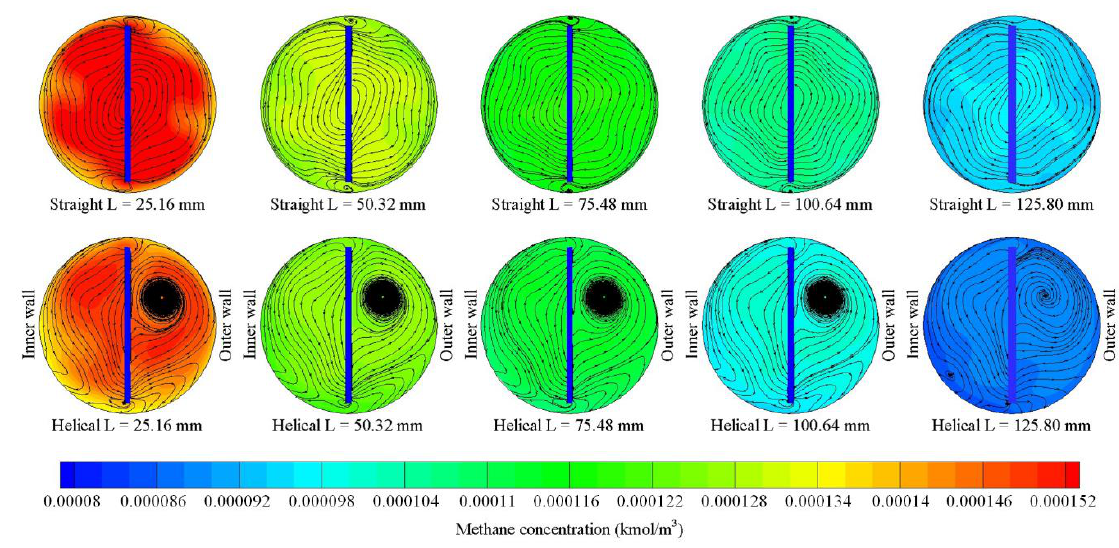
Figure 8. Methane concentration (kmol / m 3 ) and masslines of reactant flow in straight and helical reactors with insert tape twisting ratio of 3.15 at the outlet and inlet Reynolds number of 1000.